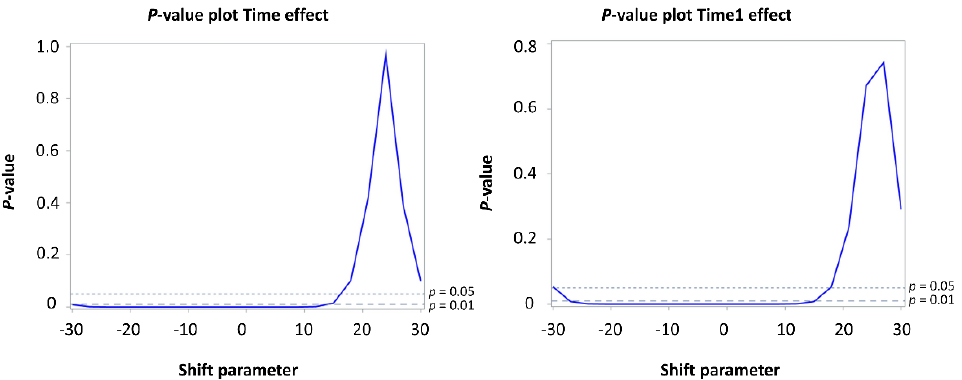
Figure 2. Tipping point analysis for shift parameters ranging from −3 0 to 30 for time effect (left) and time1 effect (right). time1 effect ( right